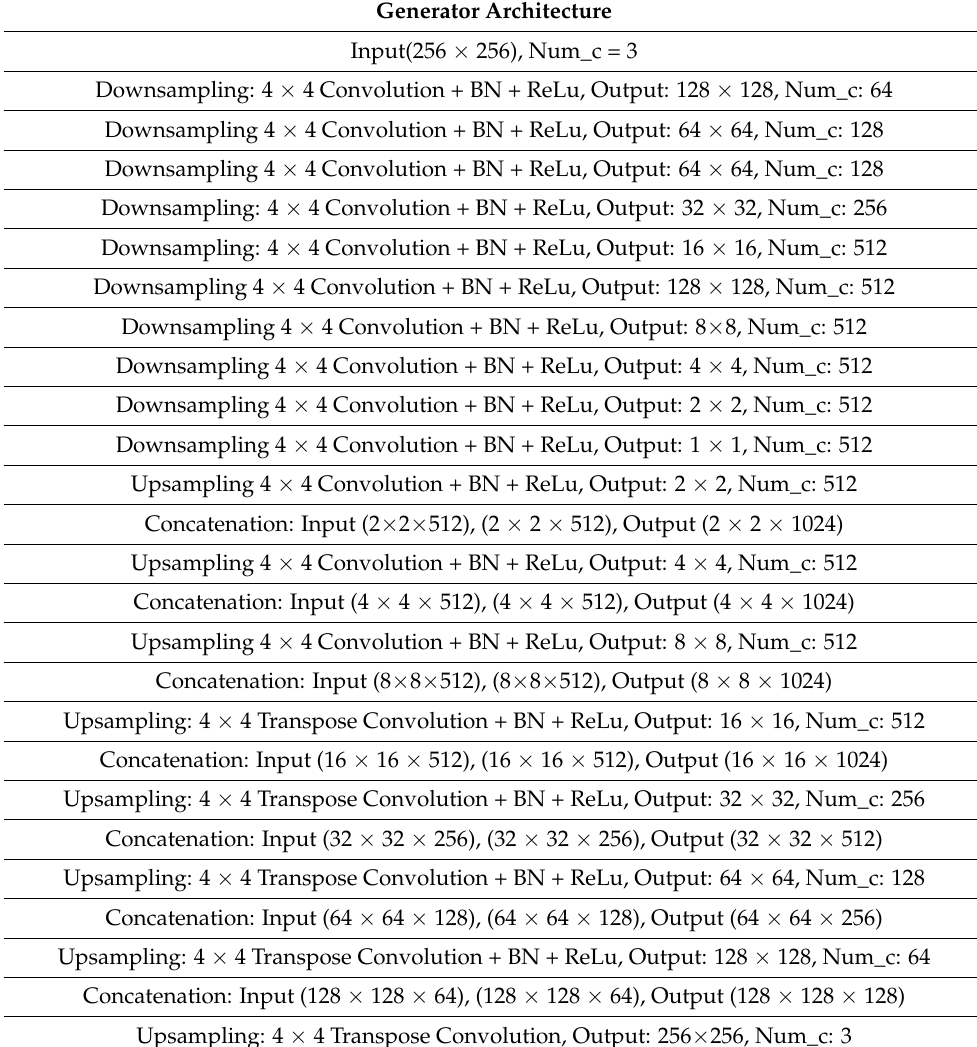
Table 1. Generator architecture of the CGANet